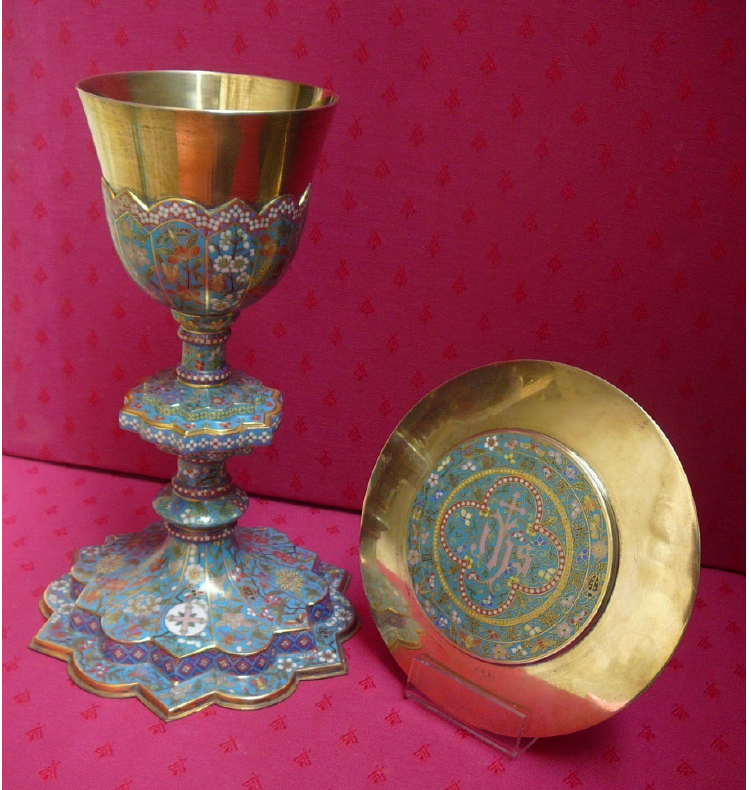
Figure 3. Chalice and its paten, 1877, China. Musée départemental d’art religieux de Sées. Photo: Musée départemental d’art religieux de Sées.